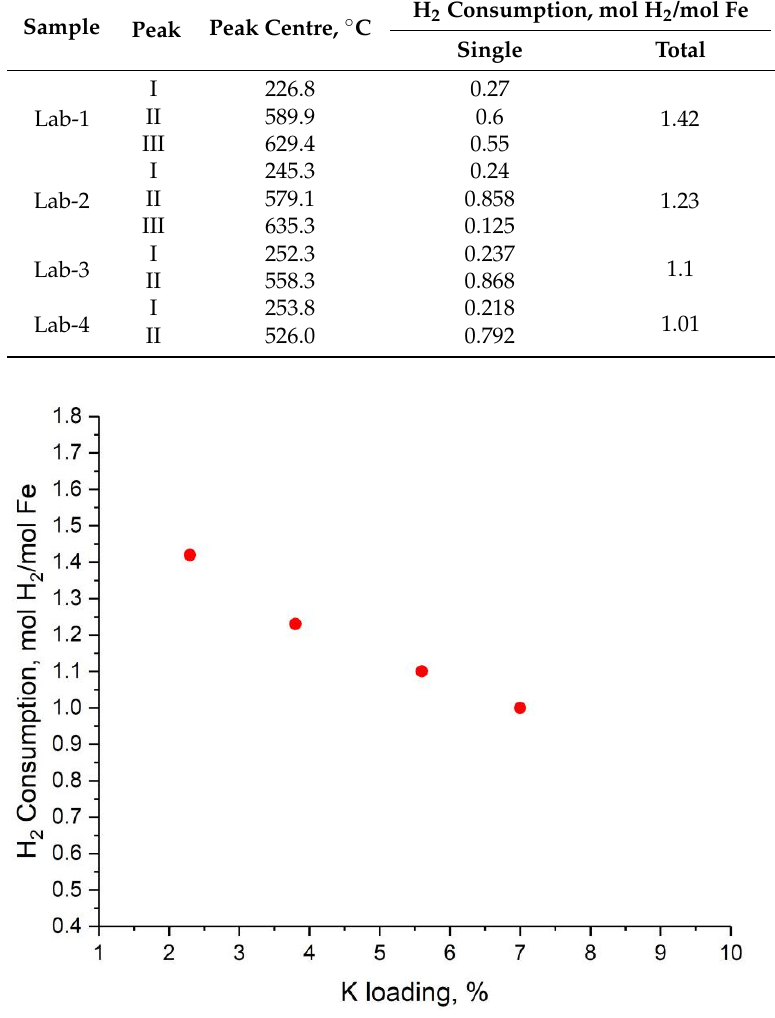
Figure 4. Total H 2 consumption during TPR for the fresh samples with different K loadings.